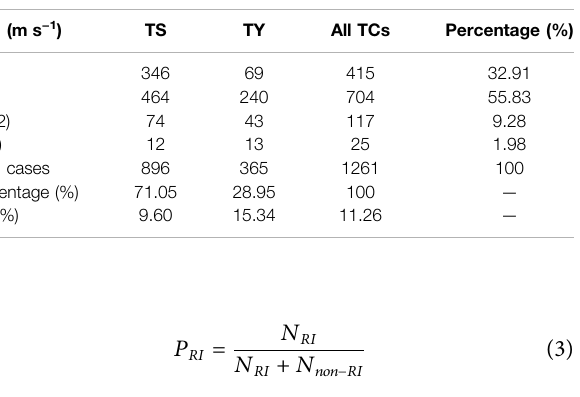
TABLE 1 | The distribution of 12-h intensity change ( Δ V 12 ) over the MSC, the number of cases in each strati fi ed intensi fi cation category in each intensity class and their percentages in the 1,261 intensi fi cation cases, and the percentage ofRIcasesineachintensityclasstothecorrespondingintensi fi cationcasesinthat category